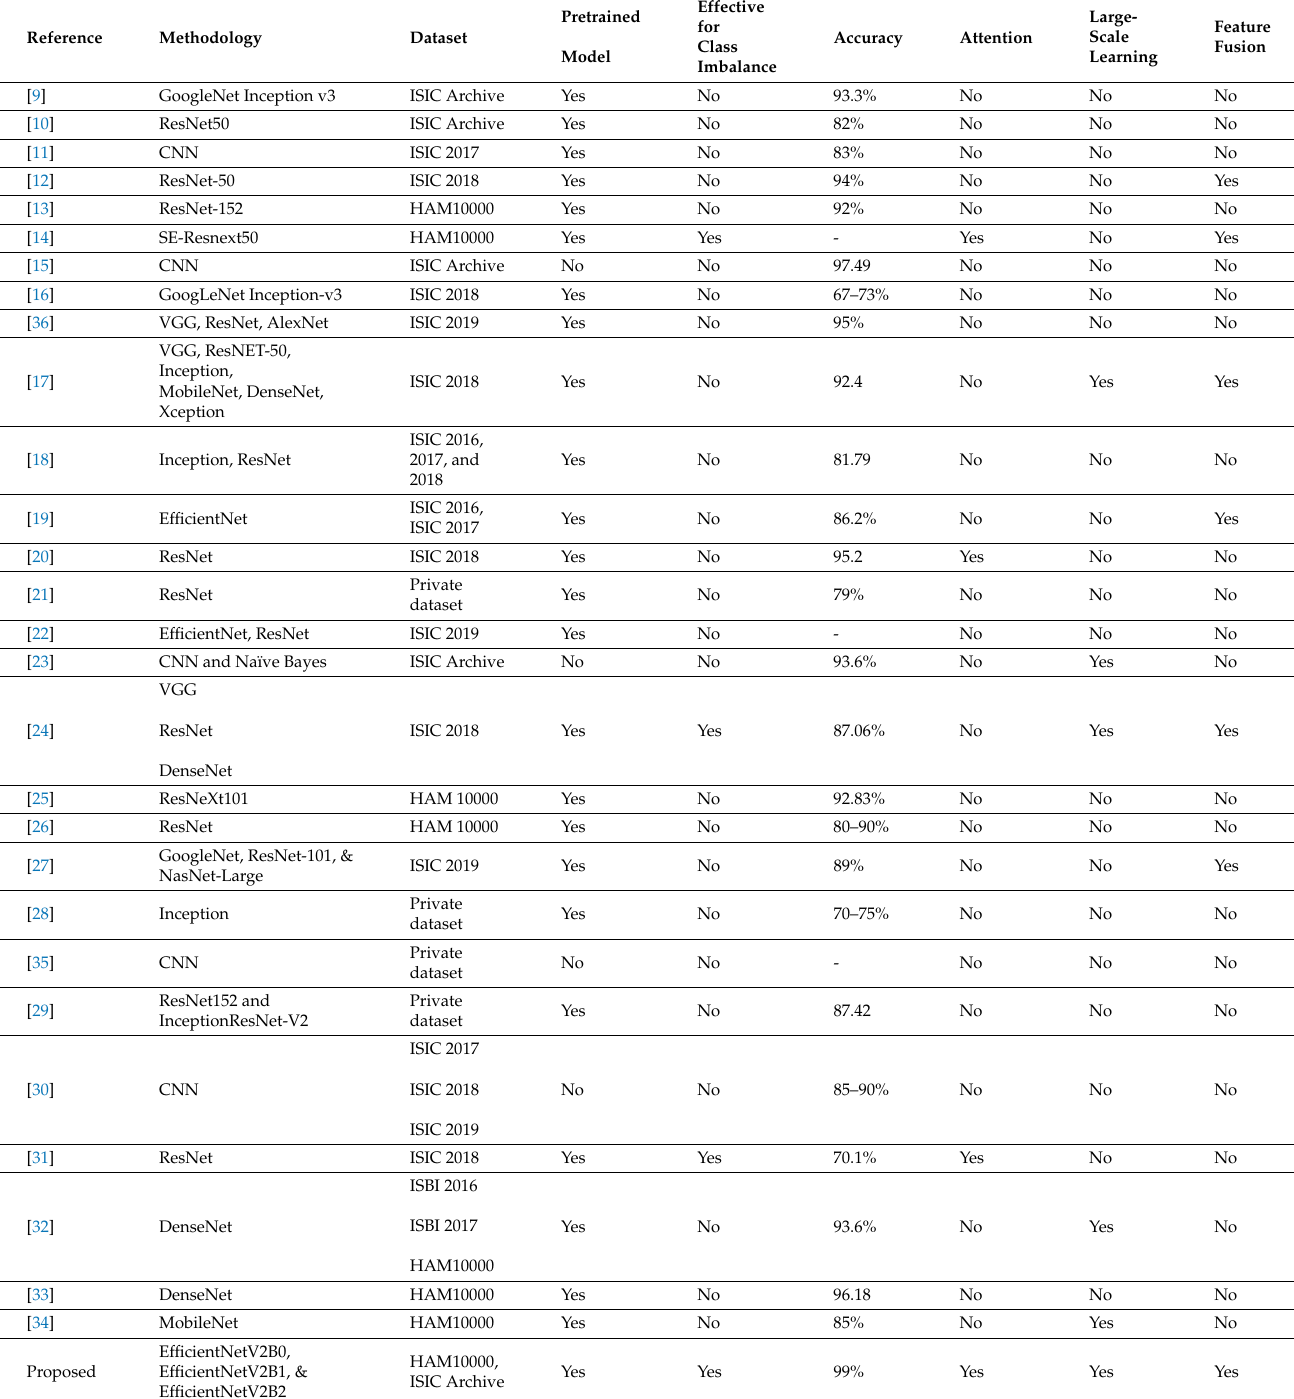
Table 1. Summary of existing methods for skin disease